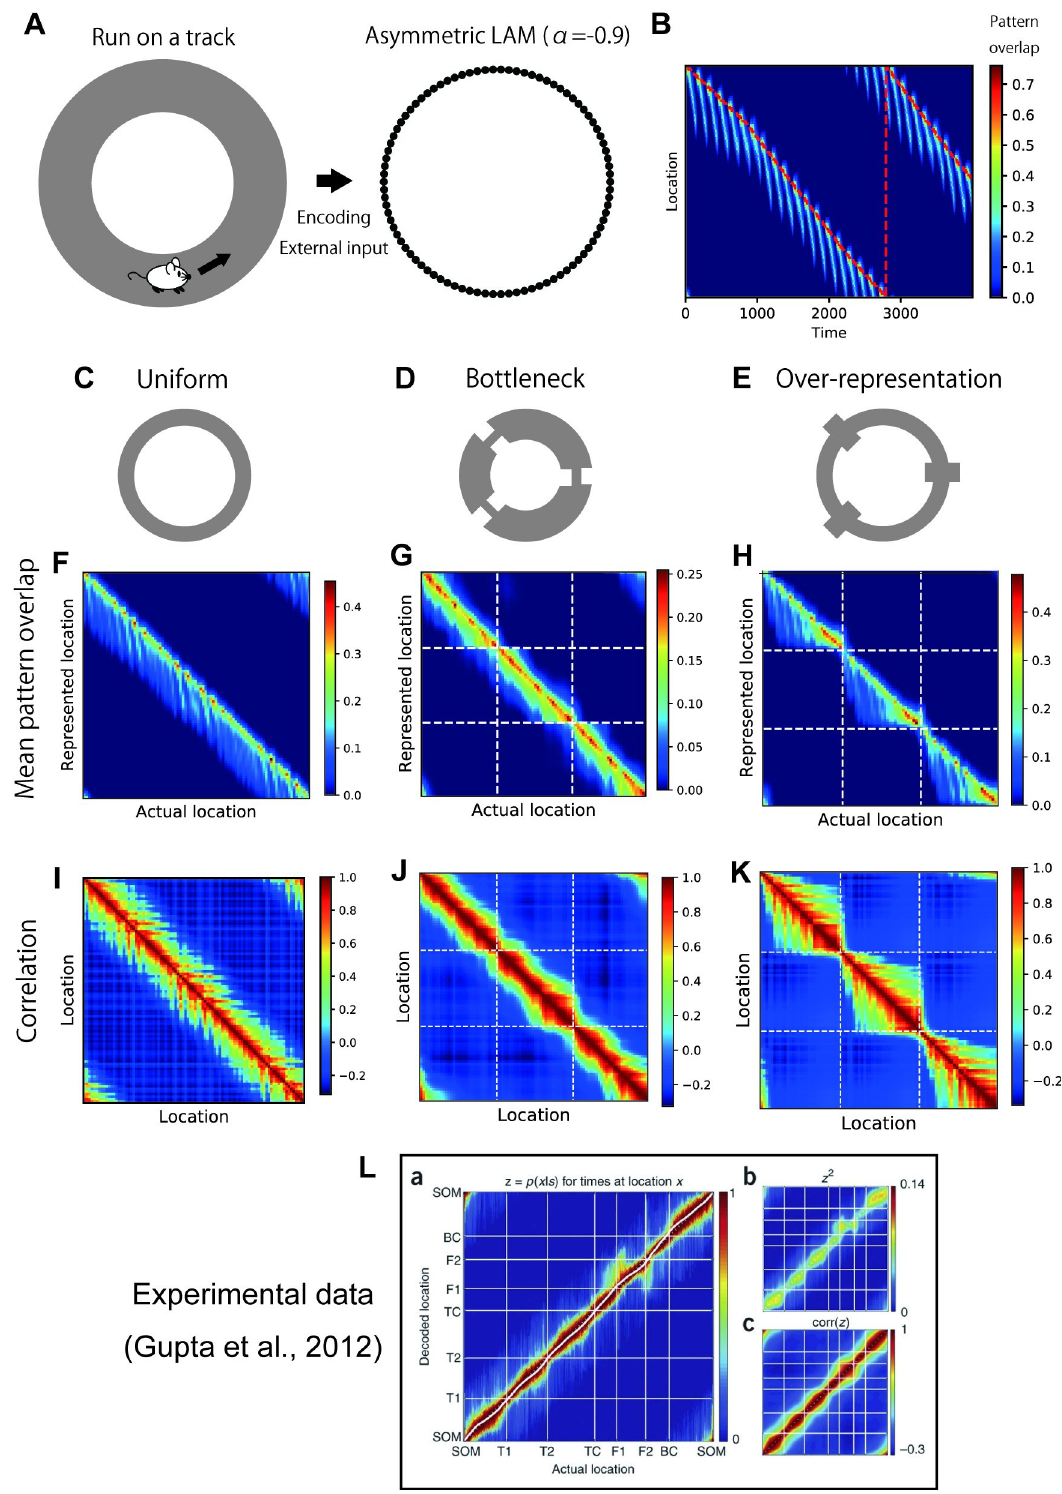
Fig 8. Chunked sequential activities in asymmetric LAM. (A) Schematics for the simulation setting. (B) Patten overlaps of simulated neural activities in the uniform model. The red dotted line indicates the actual location of the virtual animal. (C-E) Schematics of the hetero-associative link structure. A uniform ring (C), a ring chunked with local bottlenecks (D), and a ring